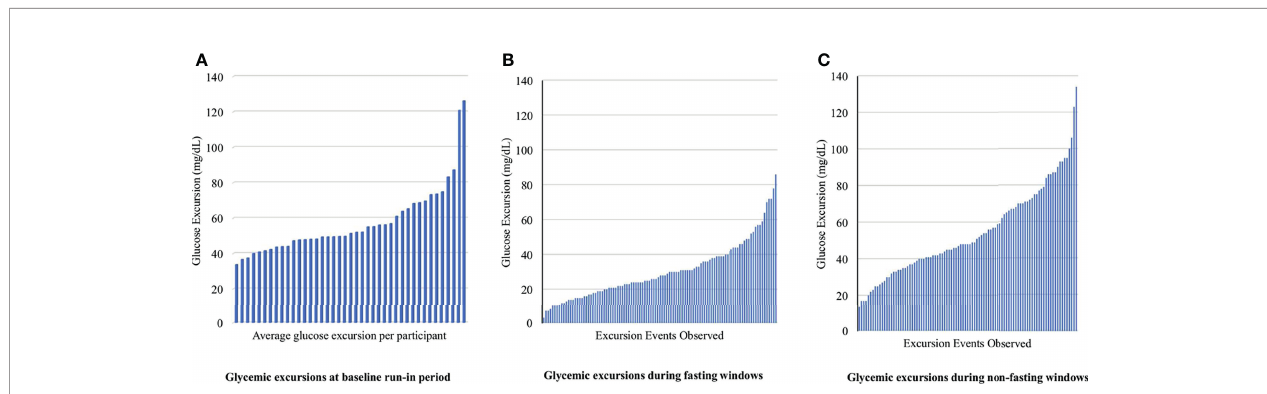
FIGURE 2 | Fasting and non-fasting glycemic excursion events observed for each participant at baseline, week 4 and 12. Glycemic excursion is de fi ned as the difference between the minimum and maximum glucose levels observed during the period of widest glycemic variability (A) displays the average glycemic excursion observed for each participant during the run-in period at baseline. (B, C) display glycemic excursion observed during fasting and non-fasting on days that 24-hour dietary recall was obtained. There were 105 unique glycemic excursion events extracted from 39 participant ’ s CGM